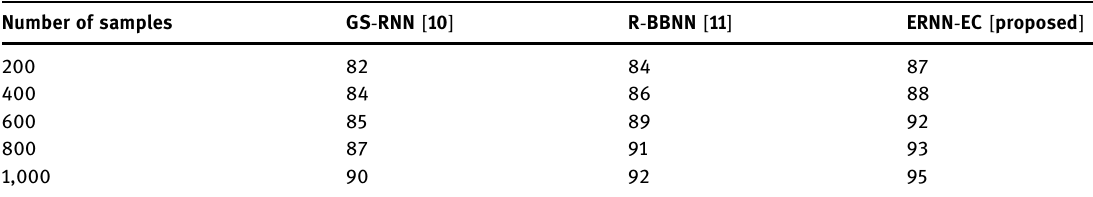
Table 4: Analysis of precision Number of